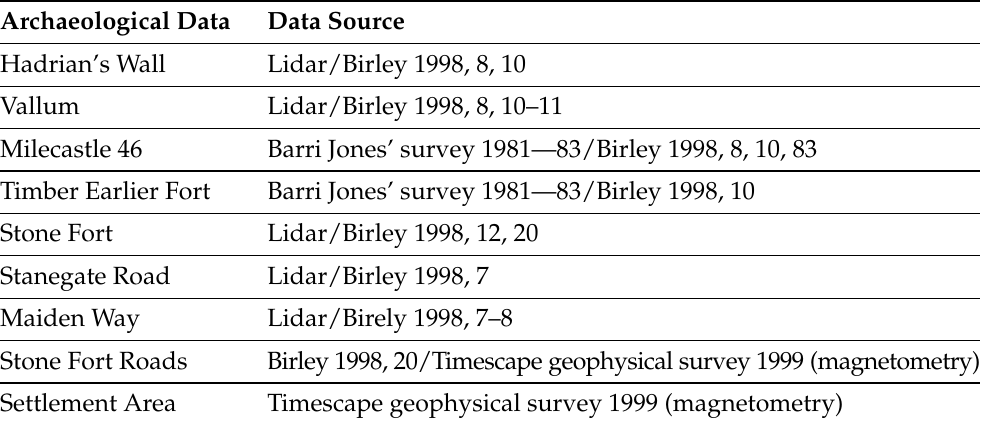
Table 1. List of sources used to define the archaeological data shown on the map in Figure